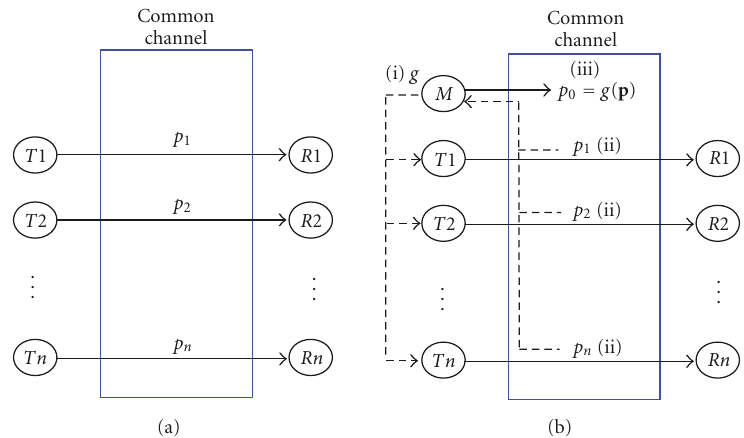
Figure 2: Schematic illustration of (a) the contention game and (b) the Stackelberg contention game. (i), (ii), and (iii) represent the order of moves in the Stackelberg contention game, and the dotted arrows represent the flows of information required for the Stackelberg contention